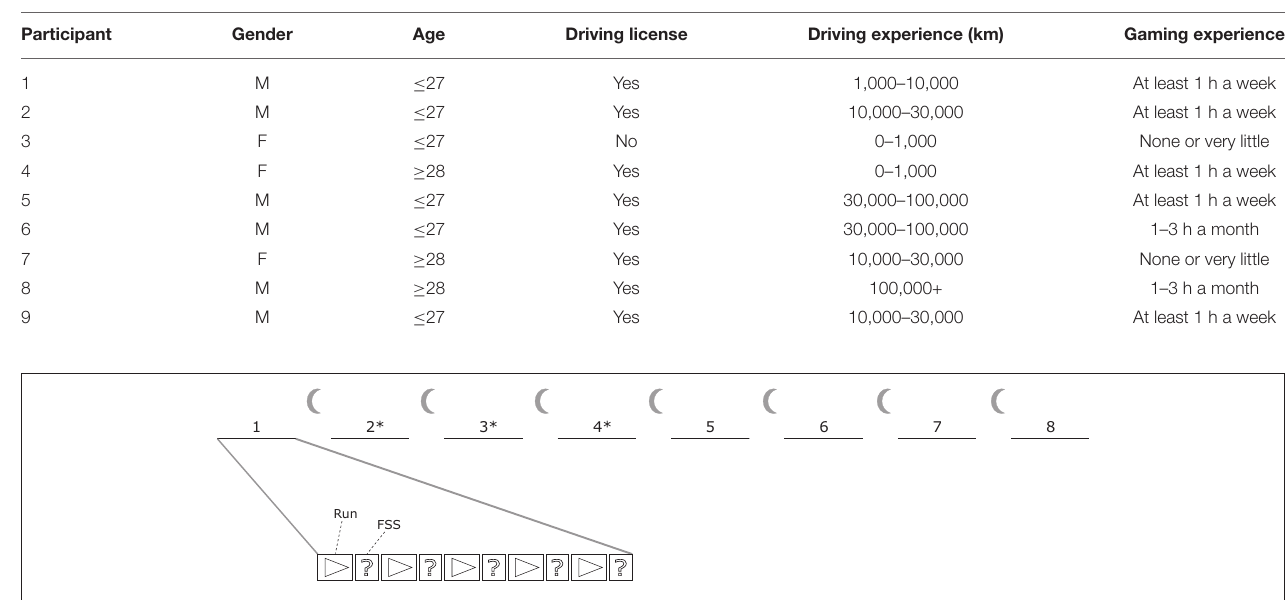
TABLE 1 | Participant background information.